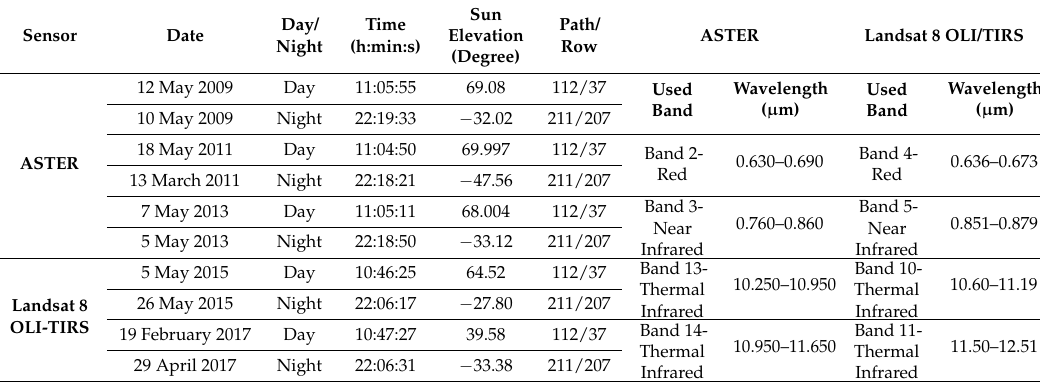
Table 1. Specification of satellite images used in this